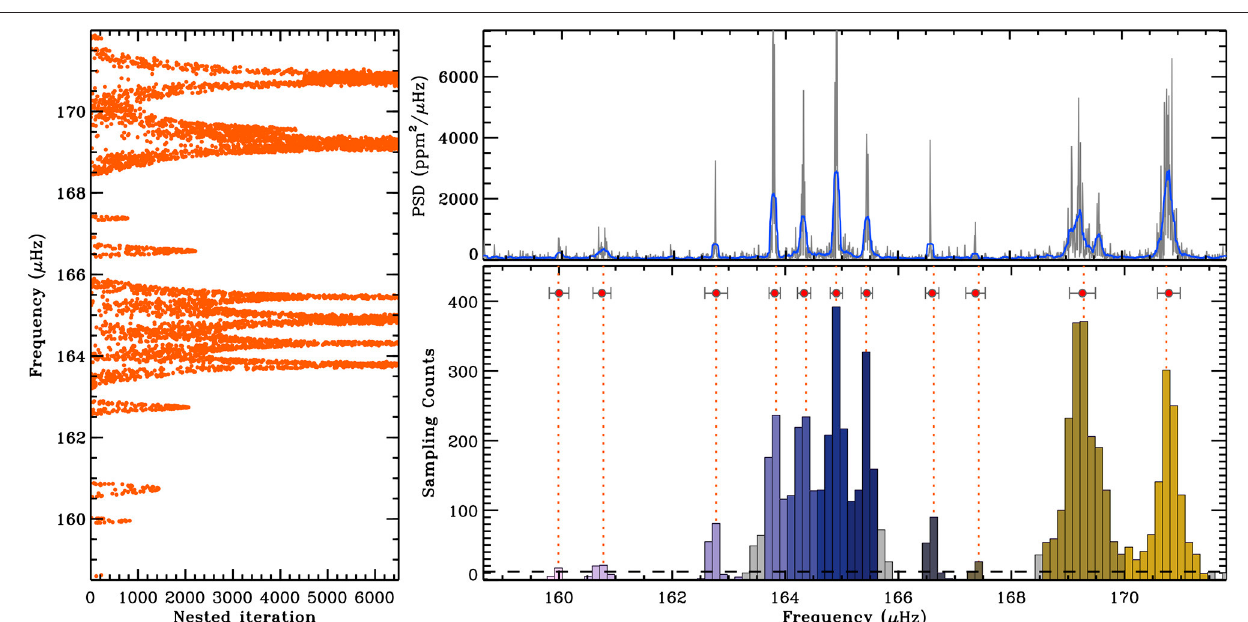
FIGURE 1 | (Left) Sampling evolution from DIAMONDS of the frequency centroid ν 0 (orange dots) as a function of the nested iteration, for the red giant KIC 12008916. Each nested iteration corresponds to one sampling point. The sampling presented is built as follows: (1) DIAMONDS performed a total of N nest = 6,000 iterations (hence 6,000 sampling points) using 2,000 live points; (2) the run is completed by adding up the set of 2,000 live points that is left at the end of the nested sampling, thus resulting in a total of 8,000 effective nested iterations (or equivalently sampling points); (3) the sampling from the first 1,500 nested iterations was removed to improve the detection of the peak structures in the PSD. This results in a final set of 6,500 nested iterations, hence of sampling points used for the analysis. (Right) (top) The PSD of the corresponding chunk analyzed (in gray) with a 10 frequency-bin smoothing overlaid (blue curve) to highlight the oscillation peak structures. (bottom). The counts histogram from the sampling, with local maxima corresponding to the extracted oscillation frequencies indicated by vertical dotted red lines, as identified by a hill climbing algorithm. The different regions of the histogram, denoted with varying colors, represent the ranges of frequency automatically selected to compute the final estimates of the oscillation frequencies and their corresponding uncertainties, according to the method (b) presented in Figure 2 . The estimated frequencies and corresponding 1- σ uncertainties from method (b) are indicated by the red circles and error bars, respectively. The horizontal dashed line represents the threshold level for the selection of the peaks, set to 3% of the maximum counts in the